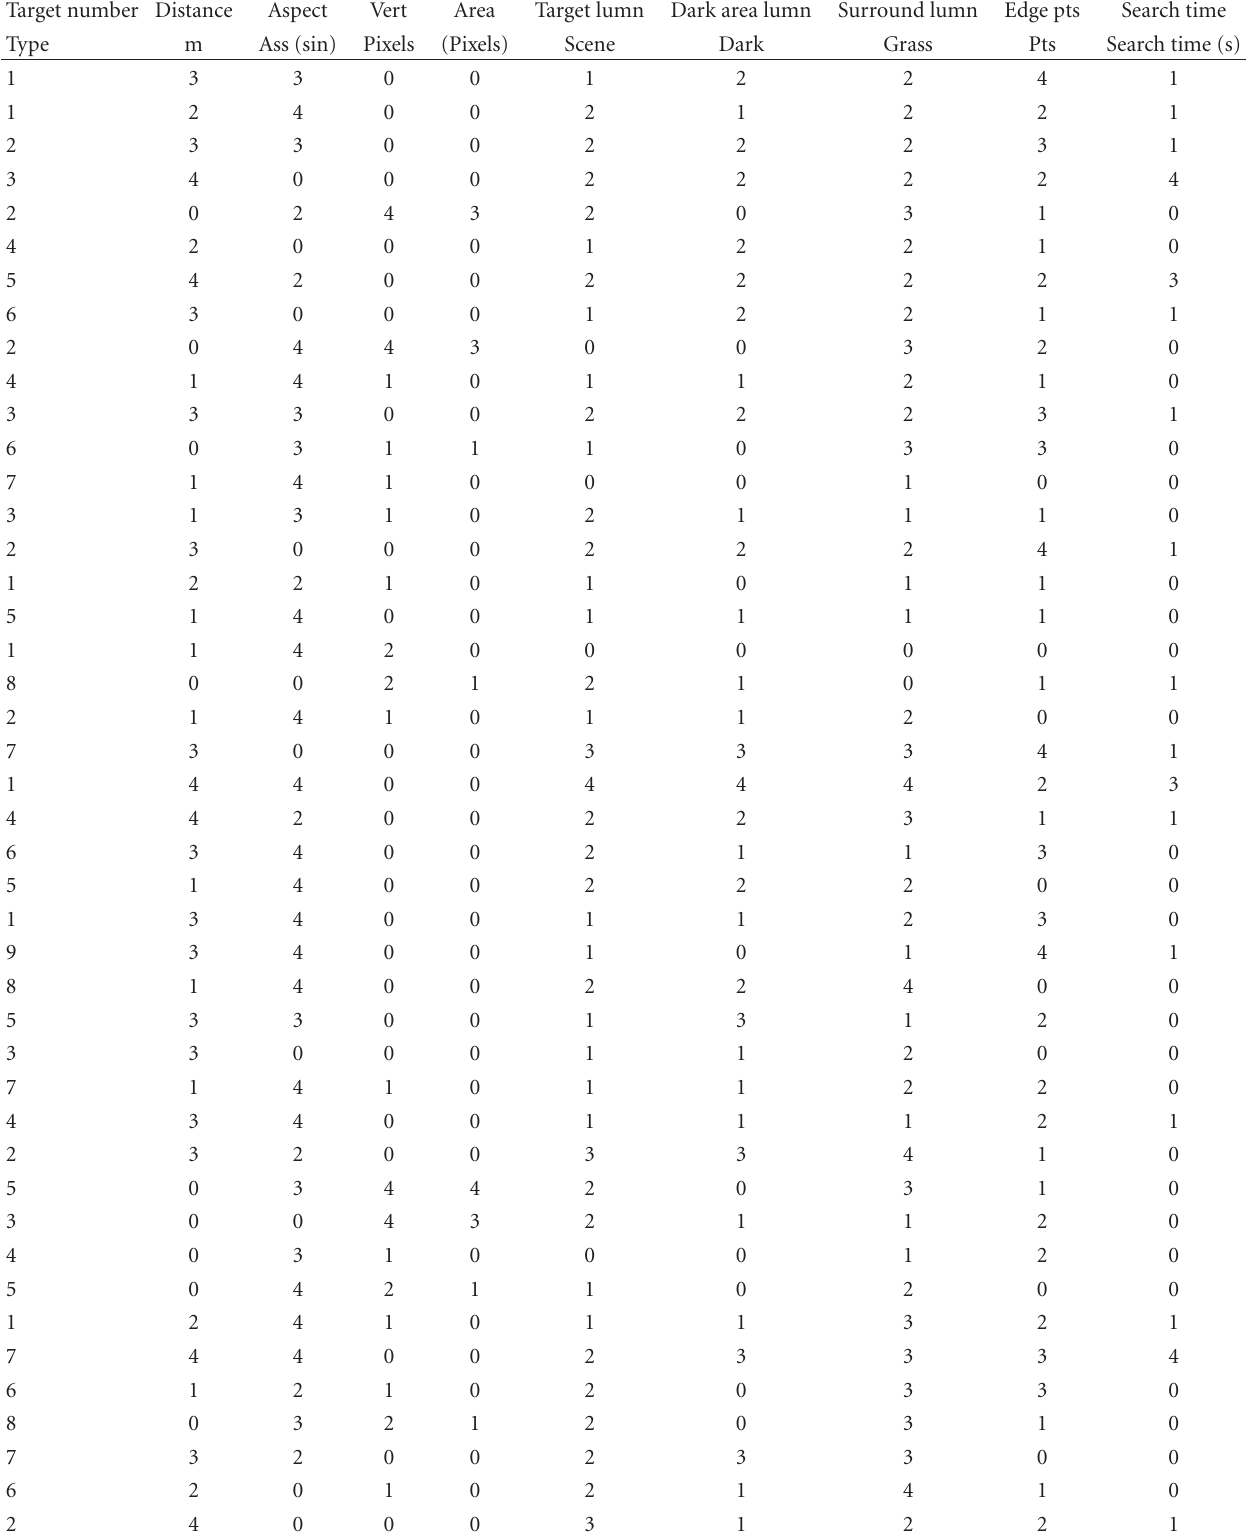
Table 6: Sample data from [5] reduced to pentalevel